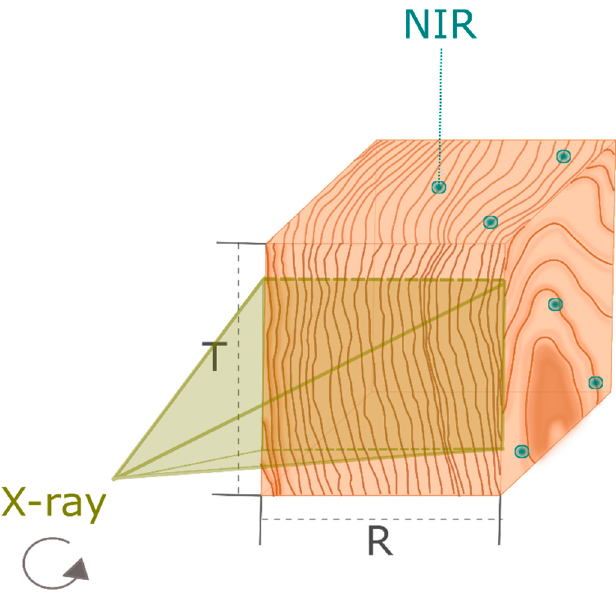
Figure 2. NIR and DAX measurement areas depicted on the wood specimen with the marked axis: tangential (T), radial (R).